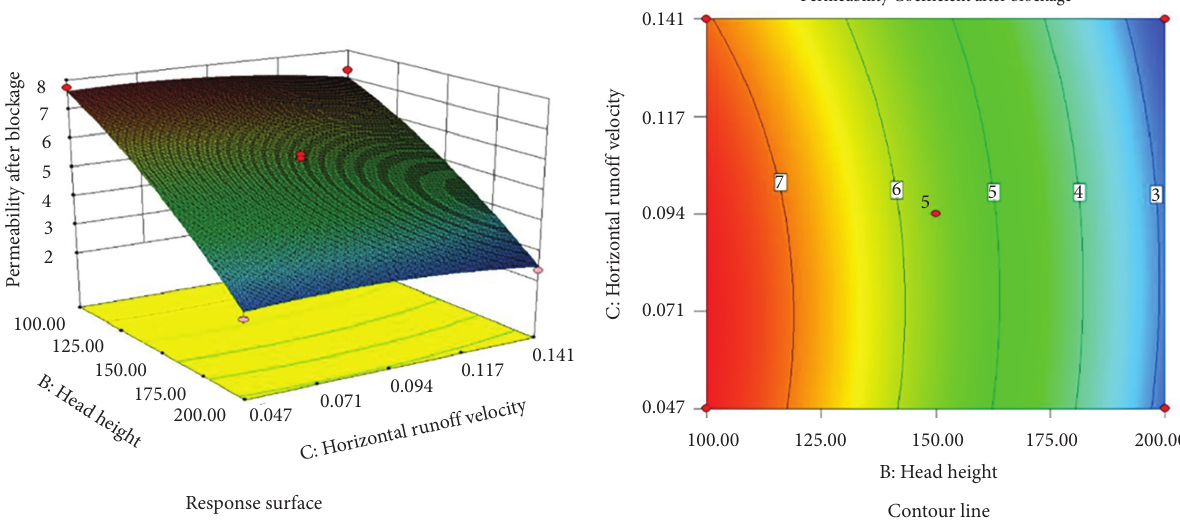
Figure 13: Effect of head height B and horizontal runoff velocity C on the permeability coefficient after clogging. Table 15: Crushing strength data of freeze-thaw PC before and after clogging.